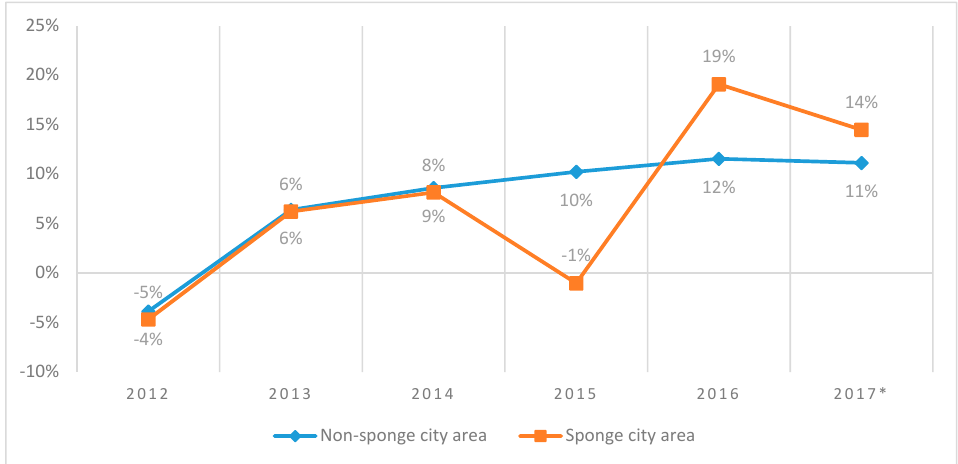
Figure 9. Annual average unit housing transaction prices in Wuhan central areas in the period 2012–2017. Source: China Index Academy, 2017.